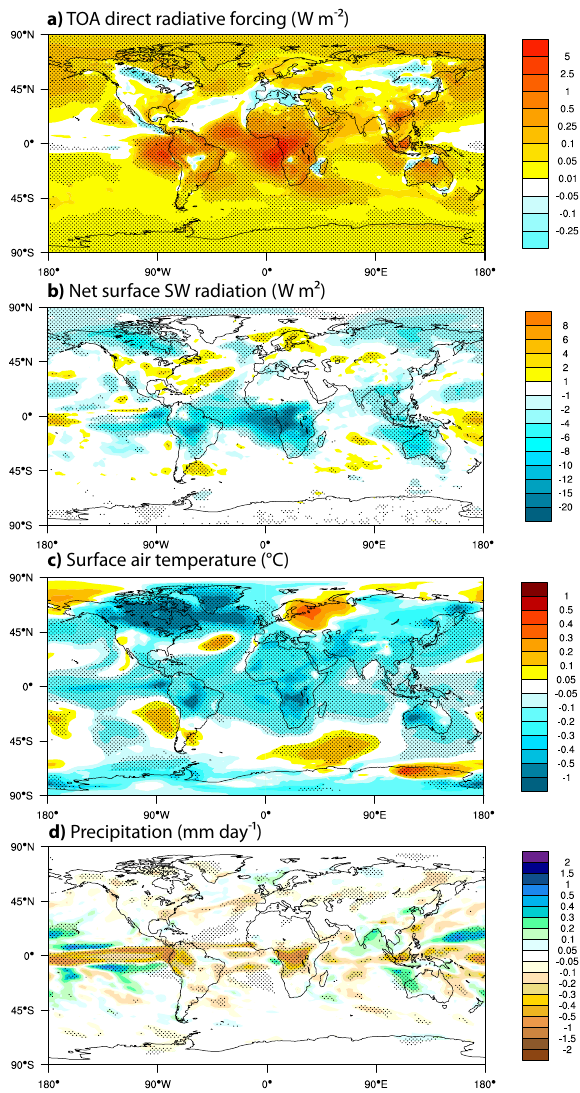
Fig. 5. Zonally averaged climate anomalies (FIRE – NOFIRE) from CAM5 simulations: (a) aerosol optical depth, (b) net insolation (W m − 2 ), (c) temperature ( ◦ C), and (d) precipitation (percent (%) change). Thin lines are seasonal averages, thick lines are annual av- erages.